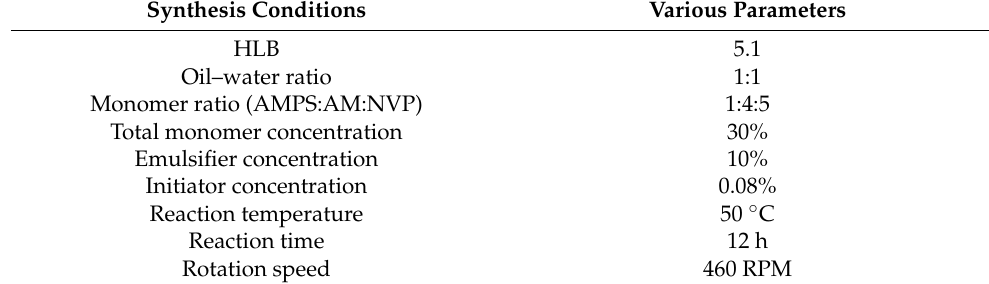
Table 5. The synthesis conditions of AMN other than cross-linker concentration.